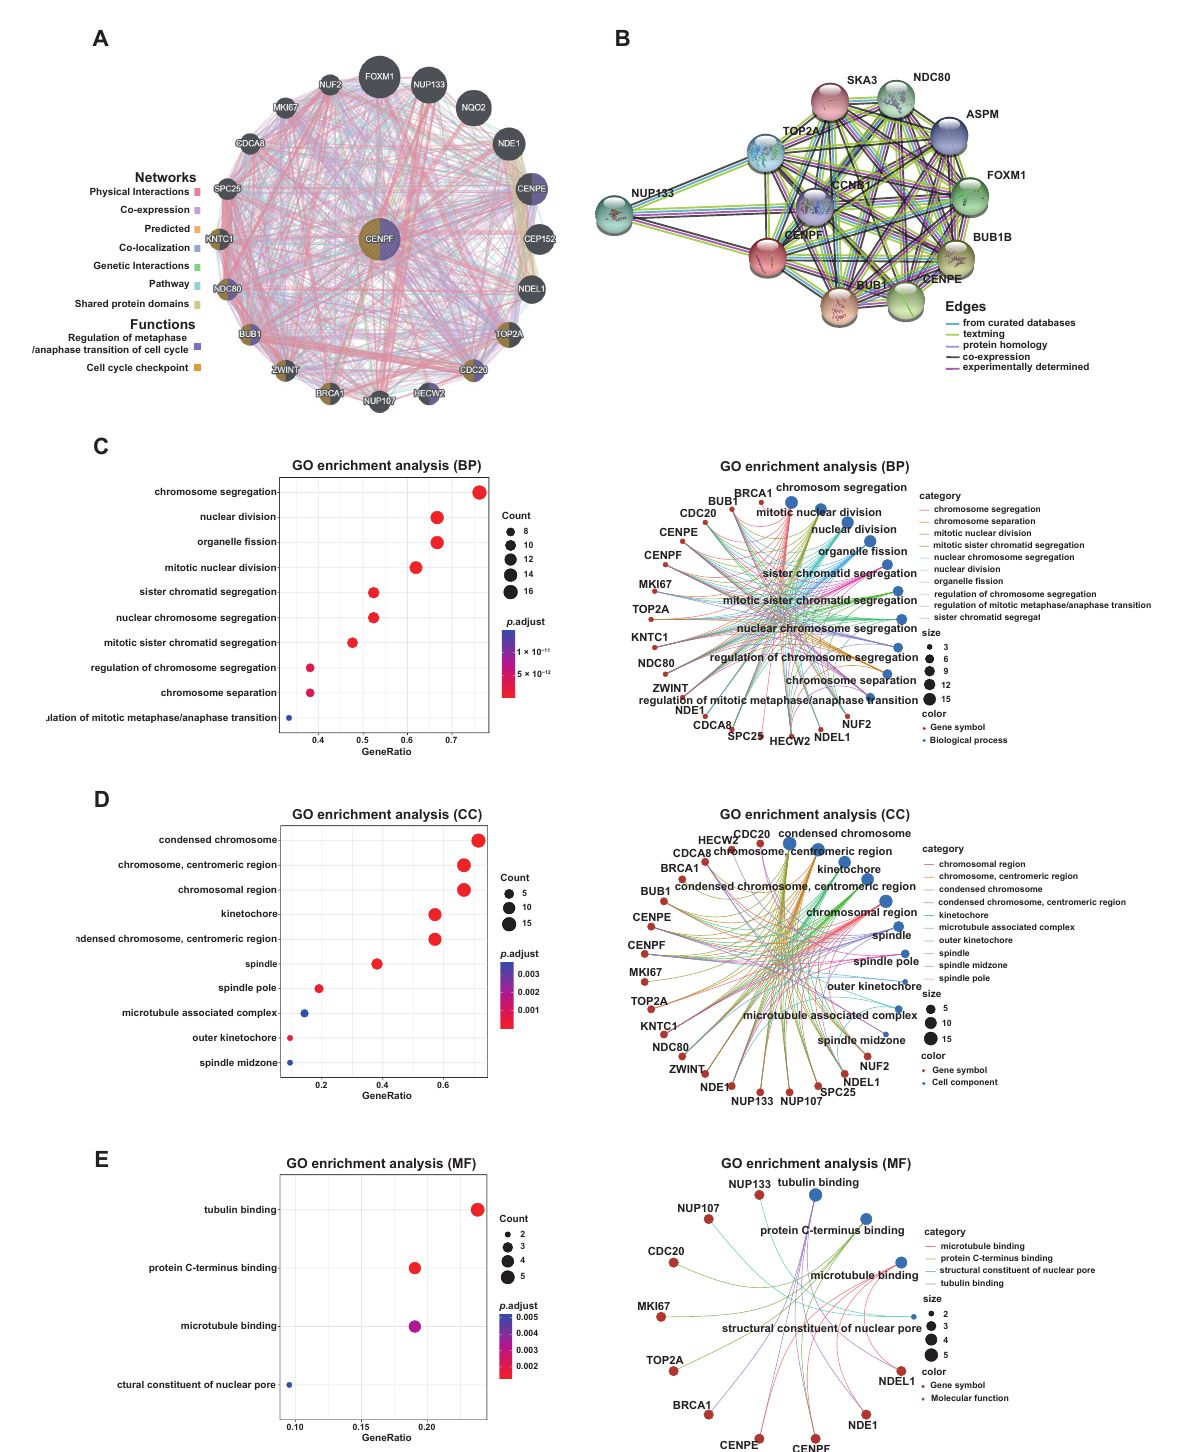
Figure 5. Gene ontology (GO) enrichment analysis of co-expressed genes of CENPF . ( A ) Co-expressed gene network of CENPF . ( B ) Protein–protein interaction (PPI) network of CENPF. The colors of lines displayed on the networks corresponded to the different interactions with CENPF. Enrichment map and gene-concept network of ( C ) biological process (BP), ( D ) cell component (CC) and ( E ) molecular function (MF). Each dot on the graph represents a group of genes, and the dot size denotes the number of these genes. A redder color indicates a more significant